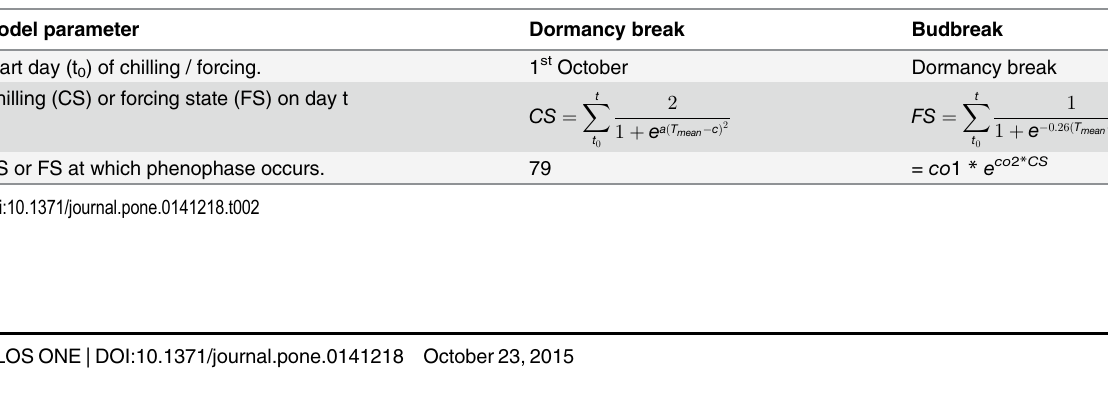
Table 2. Parameters and equations of winter-chilling models [53] used to simulate the timing of dormancy break, budbreak and flowering. Daily chilling and forcing states calculated from daily mean temperature (T mean ) and curve shape parameters a = 0.005 and c = 2.8. The same forcing equation applies to budbreak and flowering. The critical forcing state at which budburst occurs is calculated from the chilling state and curve shape parameters: co1 = 176 and co2 = 0.015. Model parameter Start day (t 0 ) of chilling / forcing.